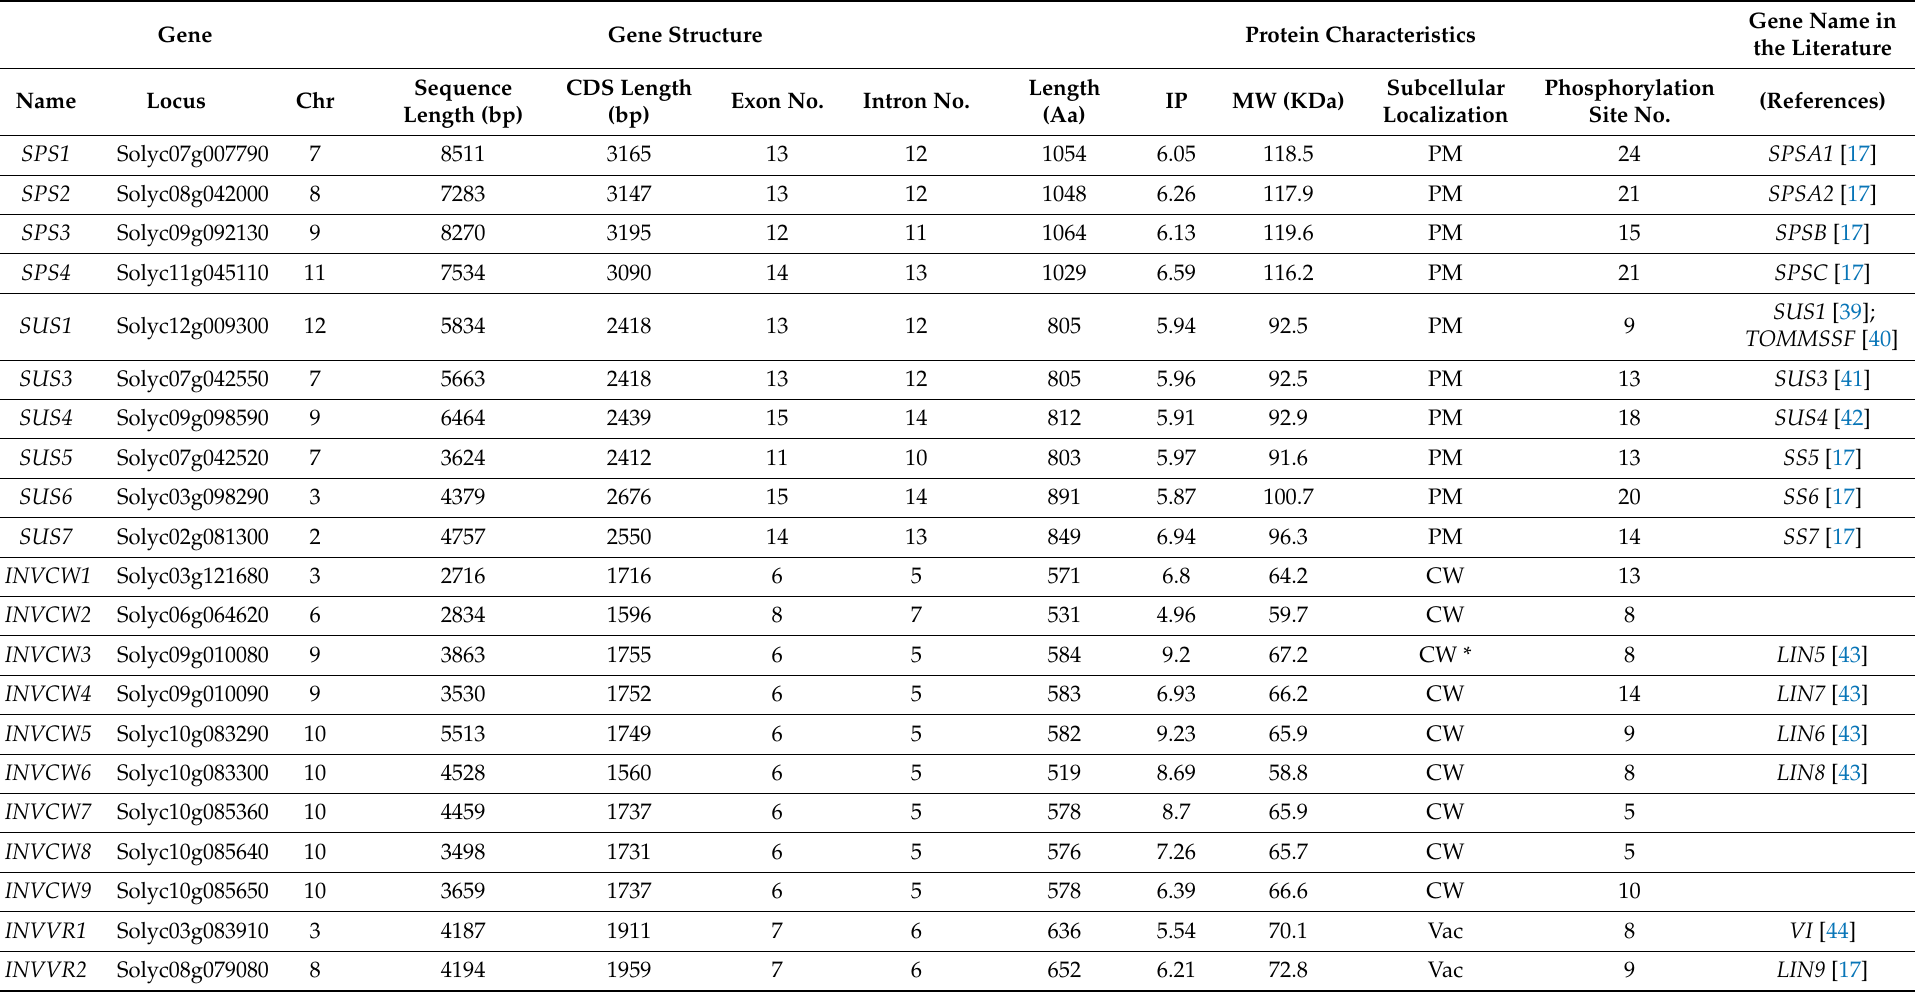
Table 1. Gene structure and protein characteristics of SUSs, INVs and SPSs in